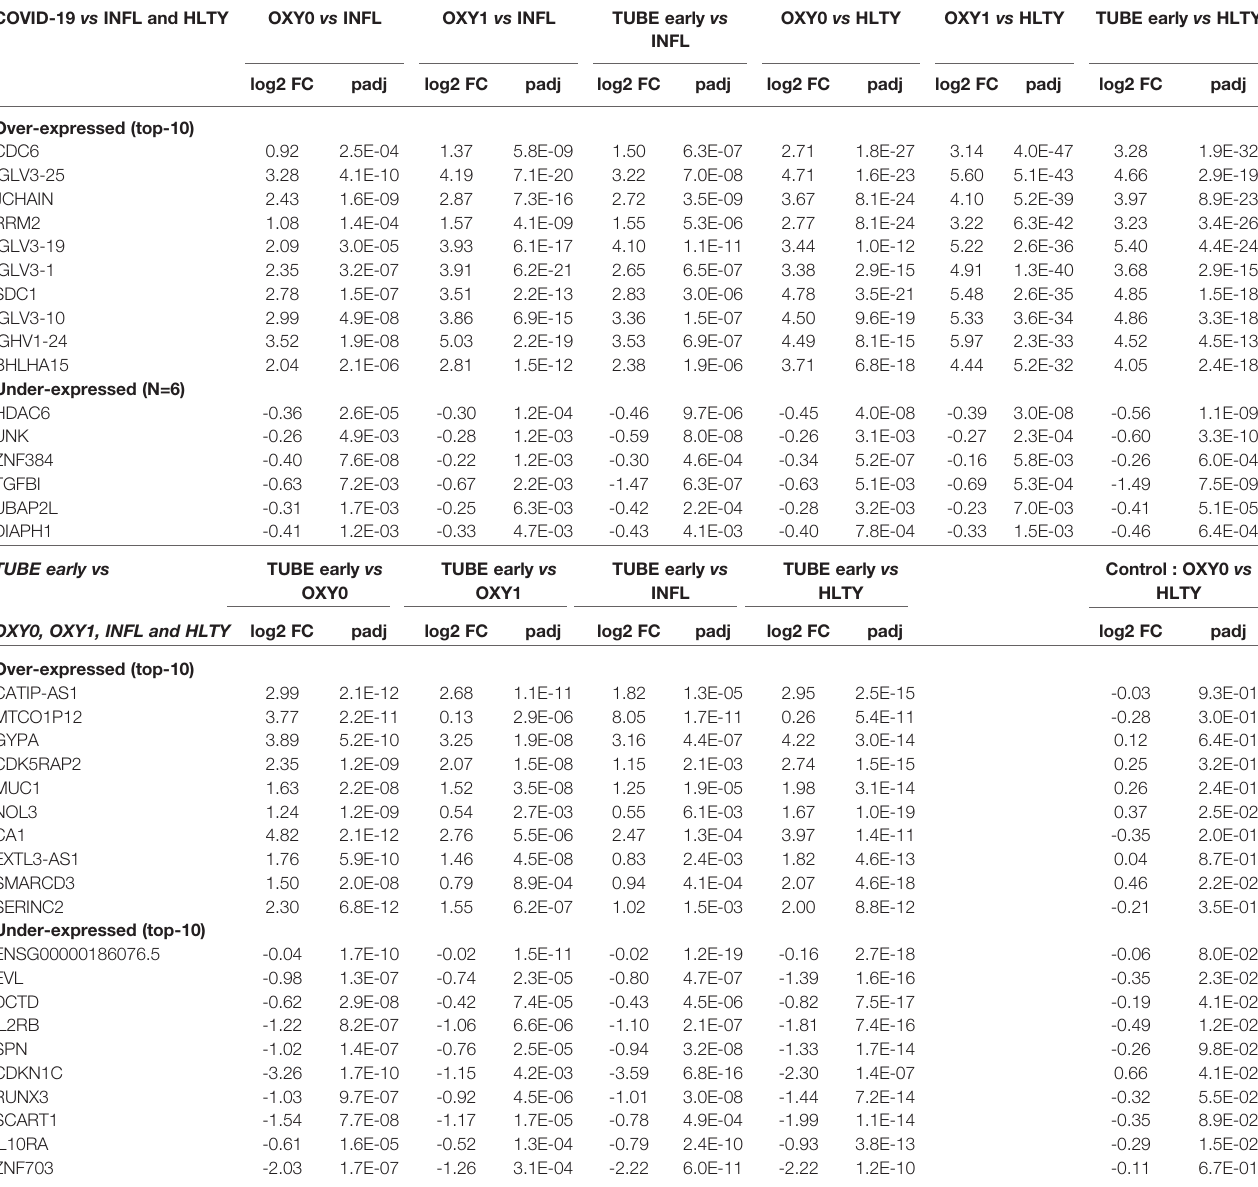
TABLE 1 | Most signi fi cant genes signatures for SARS-CoV-2 infection (upper panel) and severe COVID-19 presentation (lower panel). COVID-19 vs INFL and HLTY OXY0 vs INFL OXY1 vs